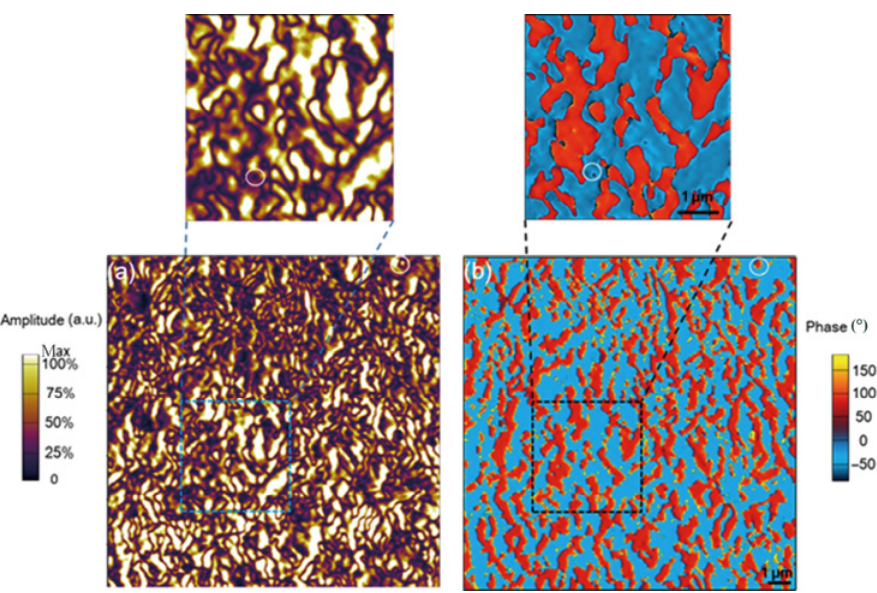
Fig. 6 Out-of-plane (a) PFM amplitude and (b) phase images of LKNNS  EuNZ  0.03BZ specimen.